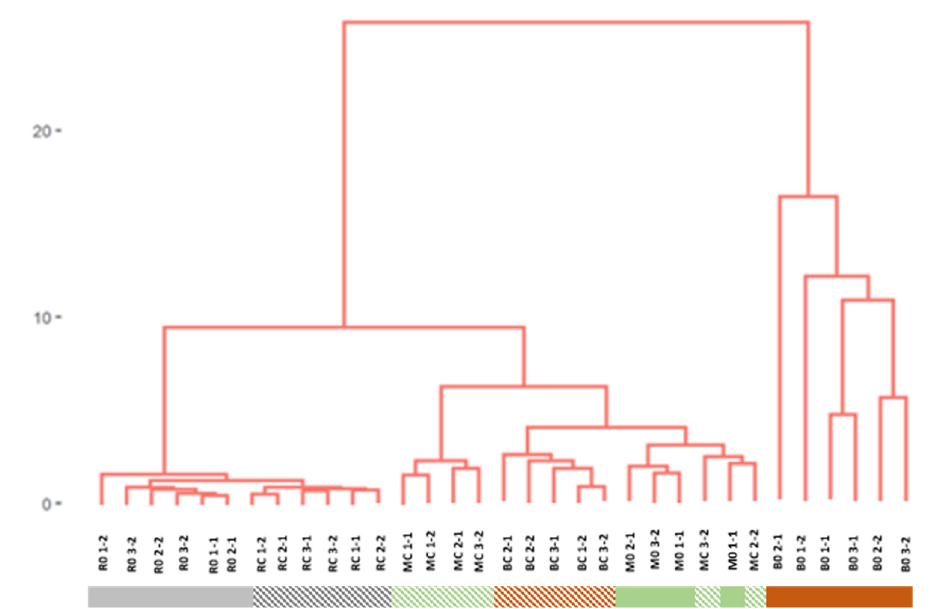
Figure 4. Results from the cluster analysis of the 33 samples from the 18 wines produced through different winemaking procedures. The individual values of monoterpene alcohols were used as variables. Codes used for wines: R: Regular winemaking process with no freezing step. M: Winemaking process with a freezing step of grape pulp and skins after destemming and crushing. B: Winemaking process with a freezing step of whole bunches of grapes. 0: Winemaking without prefermentative cold maceration. C: Winemaking with prefermentative cold maceration.